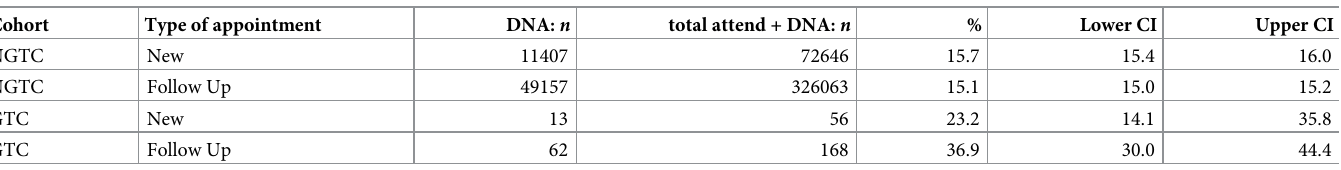
Table 4. Psychiatric outpatient DNA